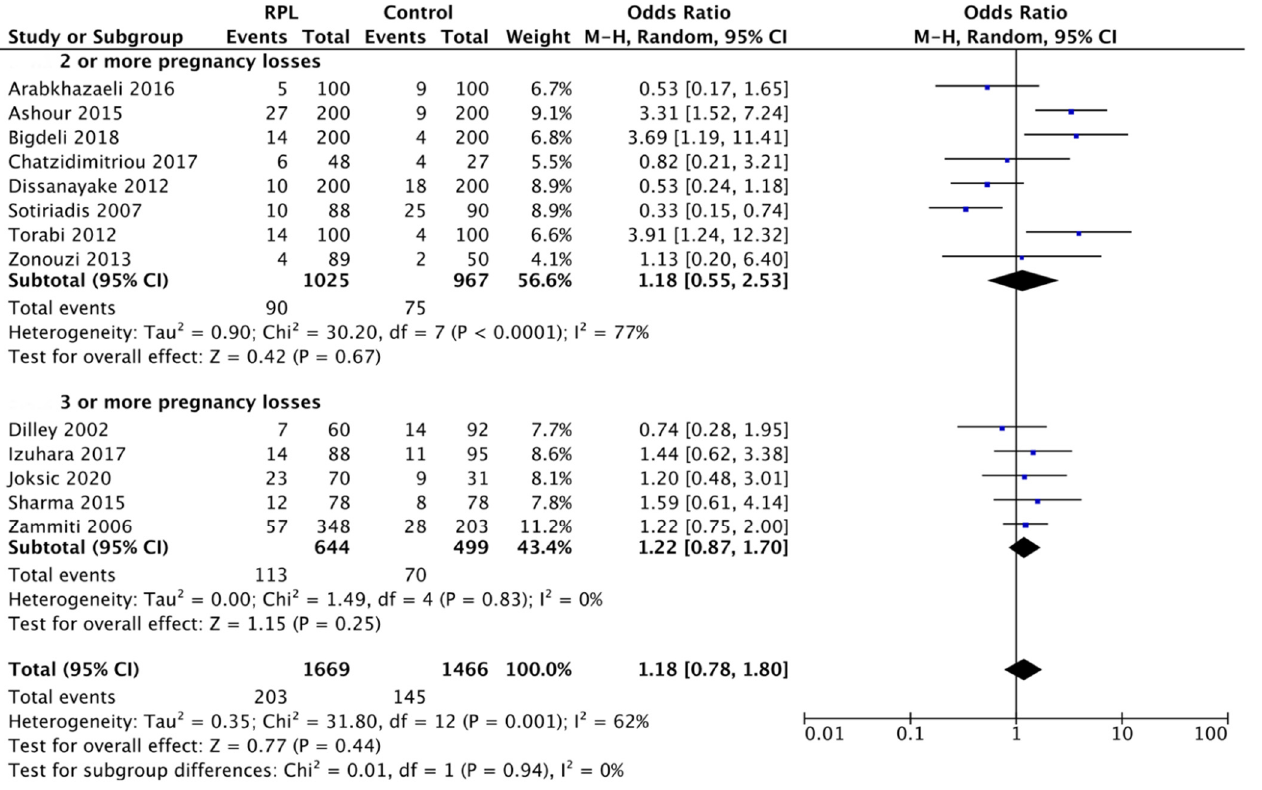
Figure 6. Subgroup analysis of the H1299R and RPL according to minimum previous pregnancy losses. The results of the meta-analysis are expressed as ORs. Black horizontal lines represent the 95% CIs of the single study. The weight given to each study is revealed by the size of the blue square. The black diamond represents the overall effect of the intervention. The statistical value I 2 indicates the heterogeneity. In the subgroup analysis the number of events indicates the presence of H1299R variant without distinction between Het and Hom. 2 or more pregnancy losses (OR: 1.18 [0.55, 2.53]; p = 0.67); 3 or more pregnancy losses (OR: 1.22 [0.87, 1.70]; p = 0.25). Overall effect OR: 1.18 [0.78, 1.80]; p = 0.44. Test for subgroup differences ( p = 0.94).